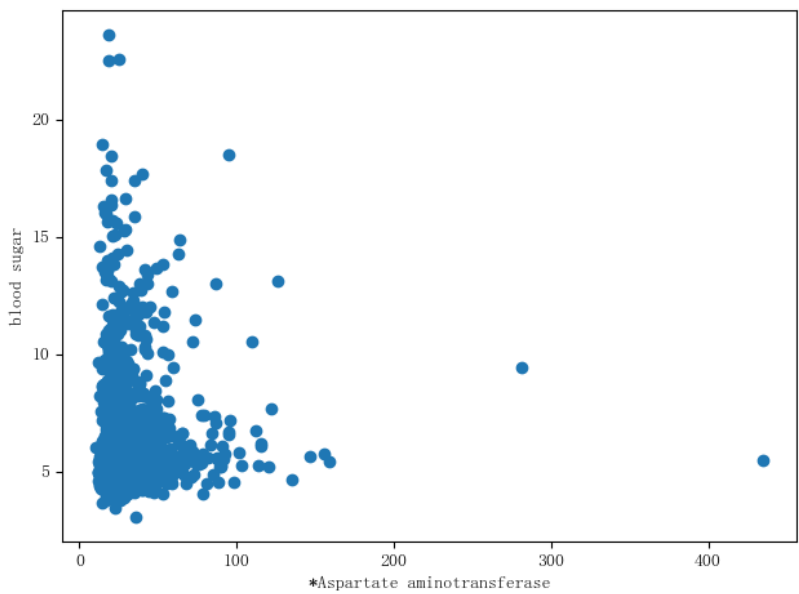
Figure 9. Scatter diagram of aspartate aminotransferase and blood glucose value.